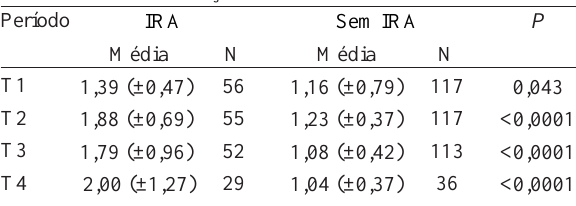
Tabela 2. Valor médio da creatinina sérica no pós-operatório de